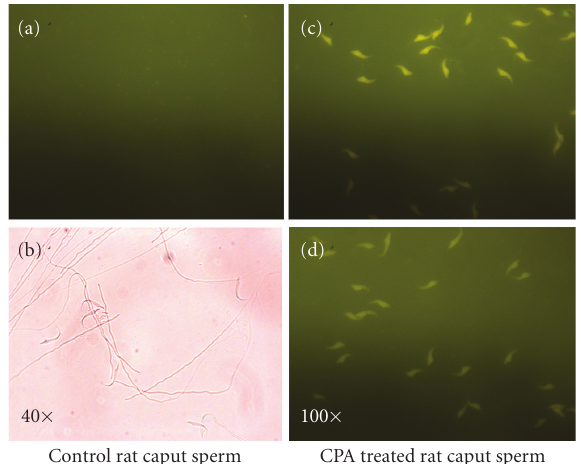
Figure 6: (a) Spermatozoa taken from untreated rats that have not picked up the CMA3 chromatin stain viewed under fluo- rescent microscope at 100X magnification at 500–610 nm exci- tation/fluorescence emission wavelength. (b) Spermatozoa of untreated rats viewed under phase contrast objective at 40X mag- nification. (c)-(d) Spermatozoa taken from the caput epididymides of CPA-treated rats that have picked up the intense yellow CMA3 nuclear chromatin stain in GC-rich regions normally occupied by protamine. Spermatozoa were fixed in Carnoy’s fixative and stained with CMA3 dye in McIlvaine’s bu ff er. Staining was viewed under fluorescent microscope at 100 X magnification at 500–610 nm excitation/fluorescence emission